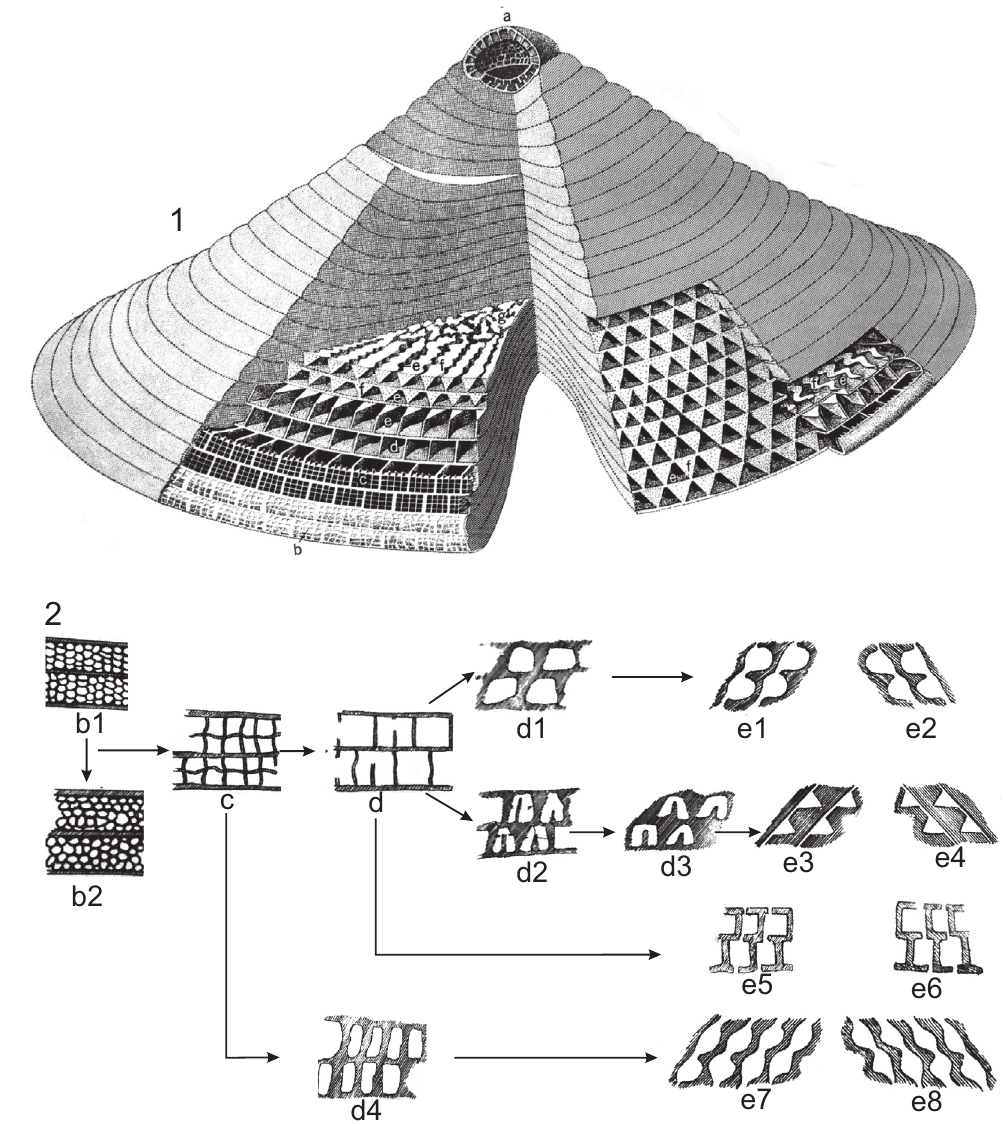
The test architecture of Orbitolina (not to scale). (1) Test dissected in several places to show the internal structures (after Douglass [52]); (2) Diagrams showing micro-structures of Orbitolina exposed by tangential sections cut progressively deeper below the